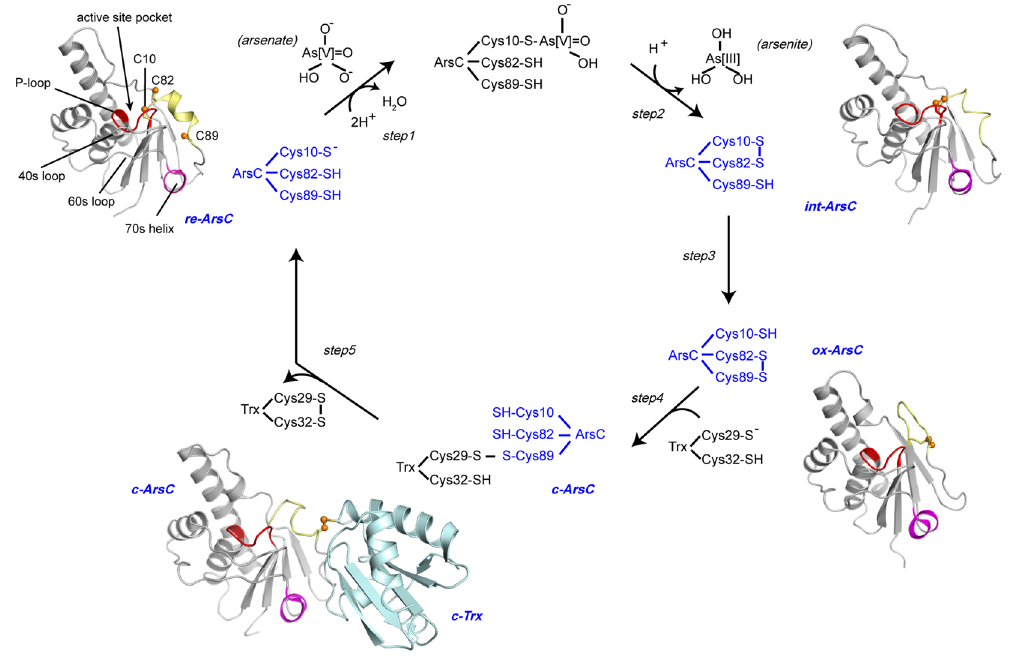
Figure 1. The catalytic mechanism of B. subtilis ArsC. Schematic presentation of the catalytic and re-activation cycle of B. subtilis ArsC. The four essential redox states re-ArsC , int-ArsC , ox-ArsC and c-ArsC are colored in blue. The structures of re-ArsC , ox-ArsC and c-ArsC (PDB entries 1z2d, 1z2e, and 2ipa) and a structure model of the C10–C82 disulfide-bonded int-ArsC generated using AMBER 54 are shown. The active site P-loop, the three active cysteine residues and other important structural regions are shown in the structure of re-ArsC